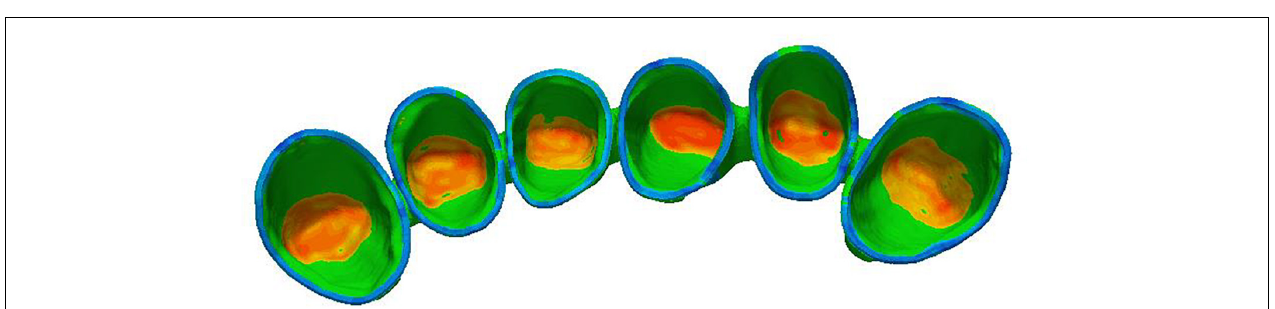
FIGURE 8 | Cosmetic defects: (A) Balling, (B) Warpage.